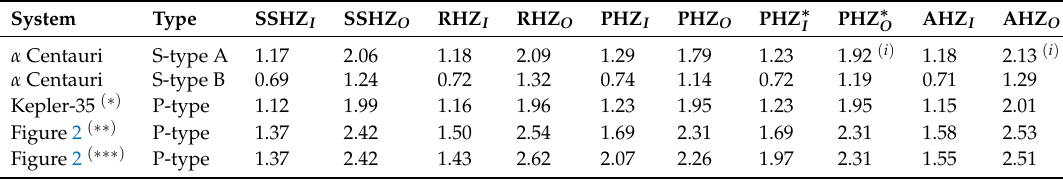
Table 4. Habitable zone borders for the α Centauri and Kepler-35 system. All habitable zone values are given in [au]. The habitable zone limits for S-type A systems are given with respect to star A, and for S-type B systems with respect to star B, respectively. Circumbinary habitable zone borders are given with respect to the barycenter of the binary. Permanently habitable zones (PHZ) are derived assuming that the planet started on an initially circular orbit, whereas PHZ ∗ values are derived for planets on orbits with forced eccentricity ( e p = (cid:101) ). ( i ) the corresponding habitable zone borders may be affected by orbital instability. ( ∗ ) In the case of Kepler-35 the single star habitable zone is derived using the combined flux of Kepler-35 A and B originating from the barycenter of the system. Stellar parameters for Kepler-35 A and B are given in Table 3. The gravitational effect of the exoplanet Kepler-35ABb has been neglected. ( ∗∗ ) same configuration as in Figure 2 right panel a b = 0.5 au, e b = 0, ( ∗∗∗ ) same configuration as above only with e b =